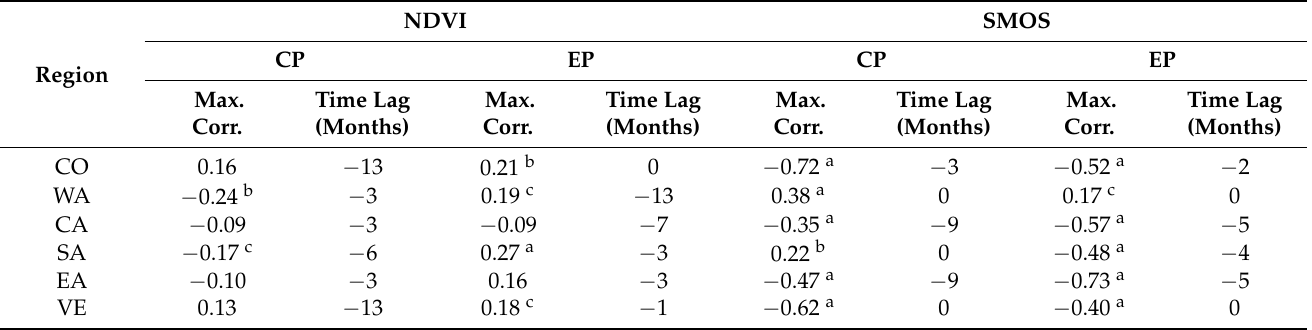
Table 6. Maximum lagged correlation coefficients and associated time lags between time series of standardized NDVI and SMOS with the CP and EP